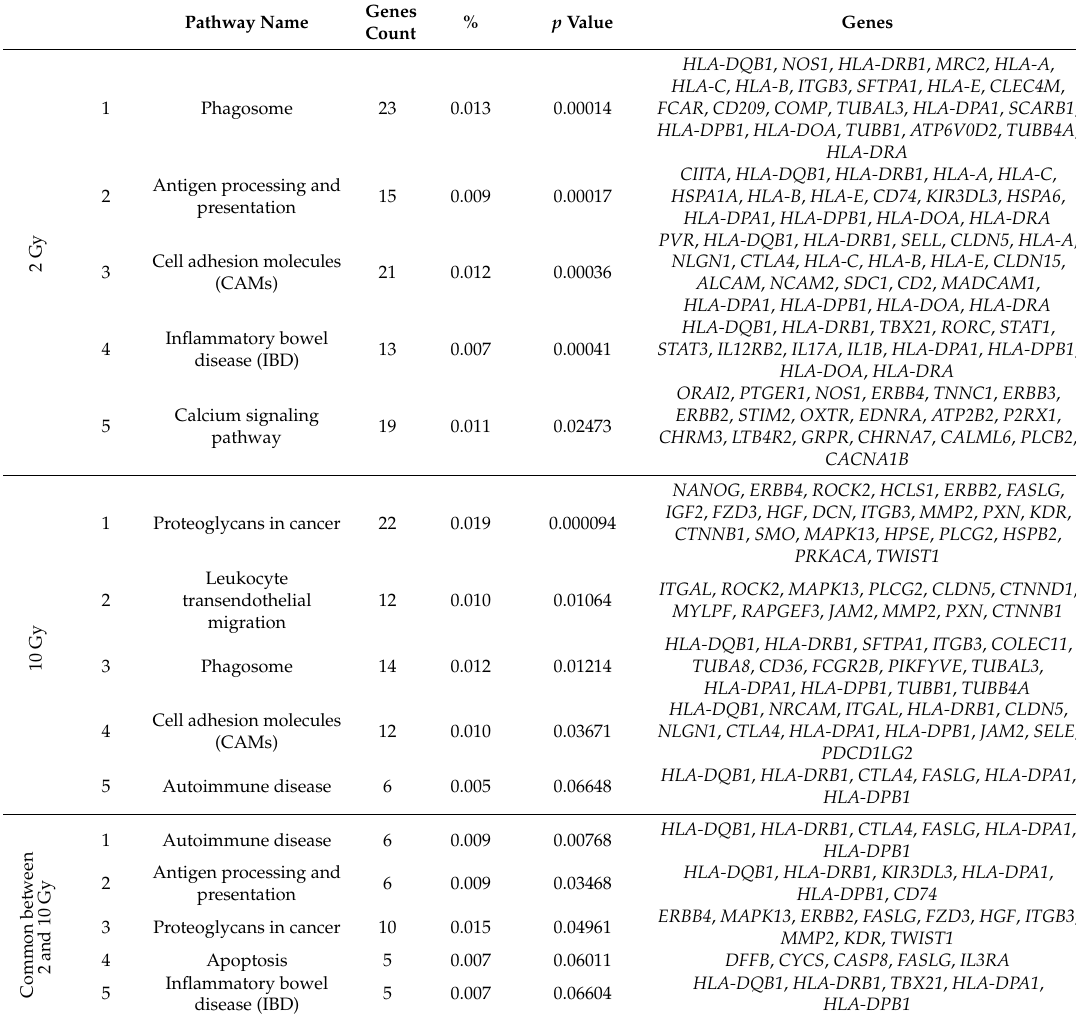
Table 7. Top-five Statistically relevant pathways activated in U87 cells pretreated with Si306 and exposed to